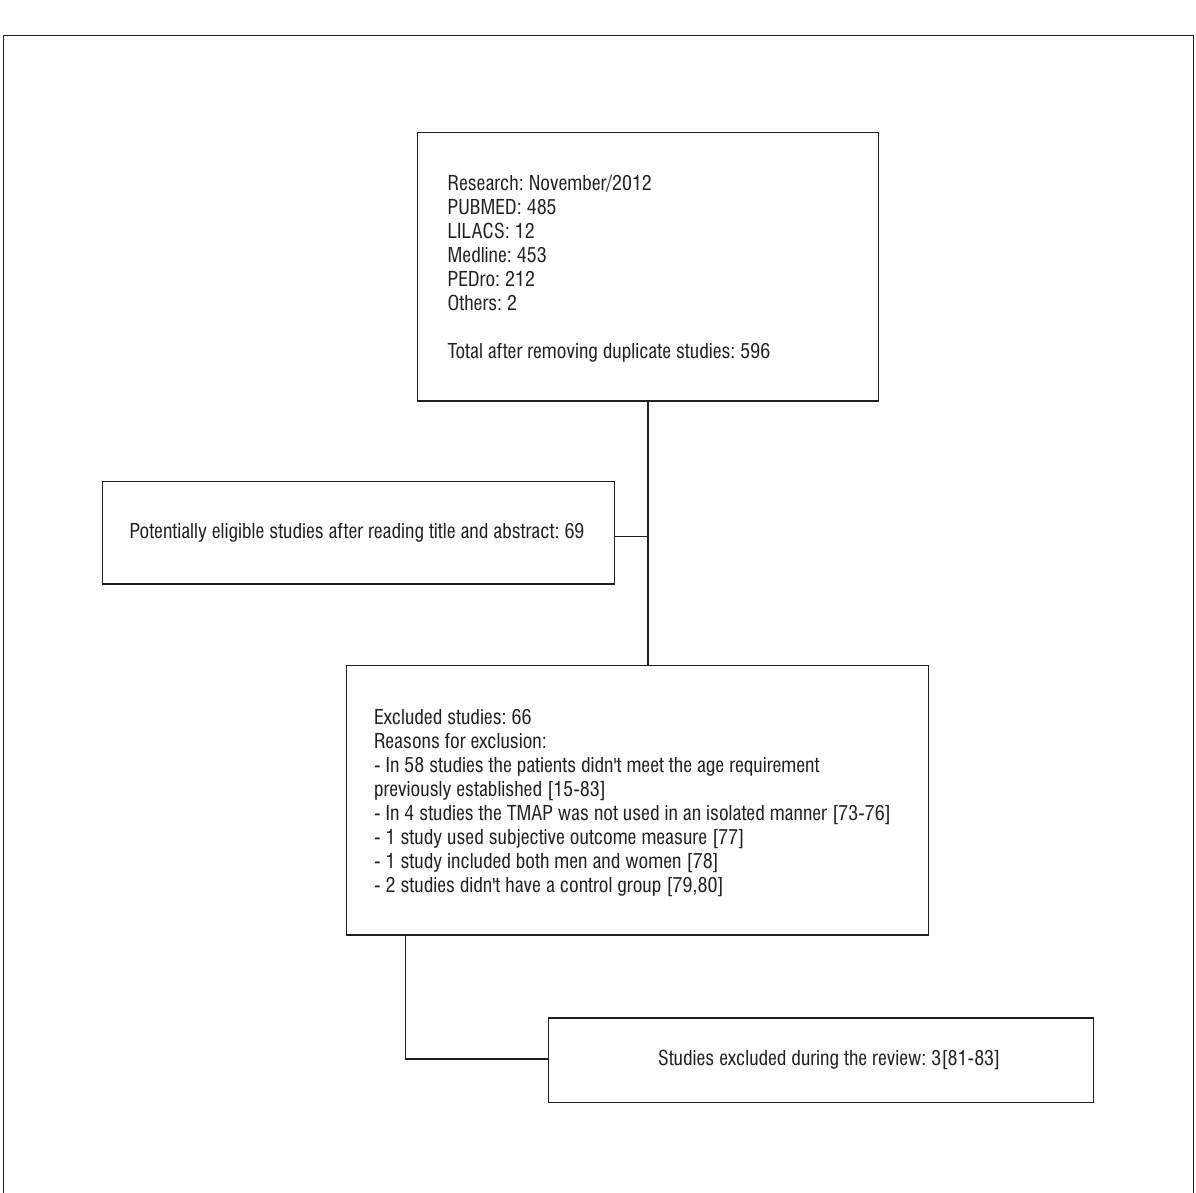
Figure 1 - Detailed flowchart demonstrating the selection process of the